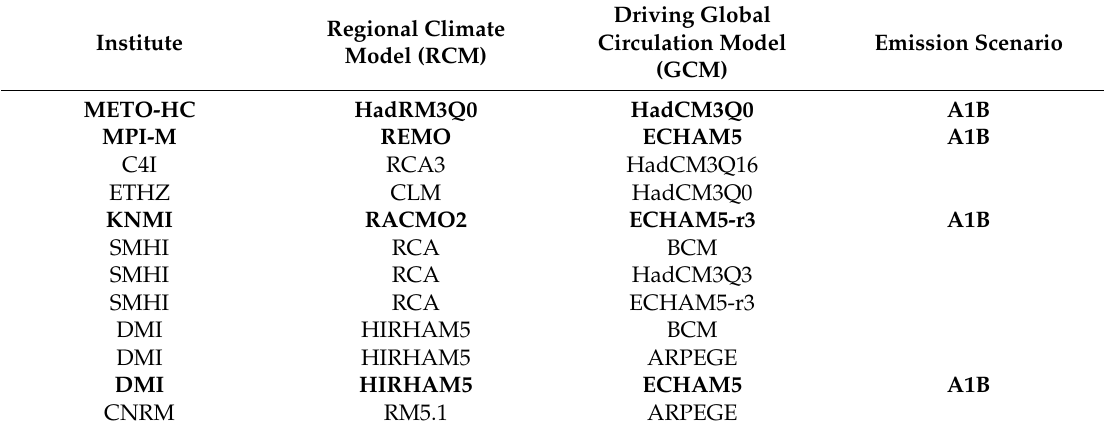
Table 2. List of model runs available for this study (adapted from Dosio et al. [29]). The selected models are highlighted in bold characters. (For a full description of the Institutes’ and model acronyms see Christensen et al. [30]).